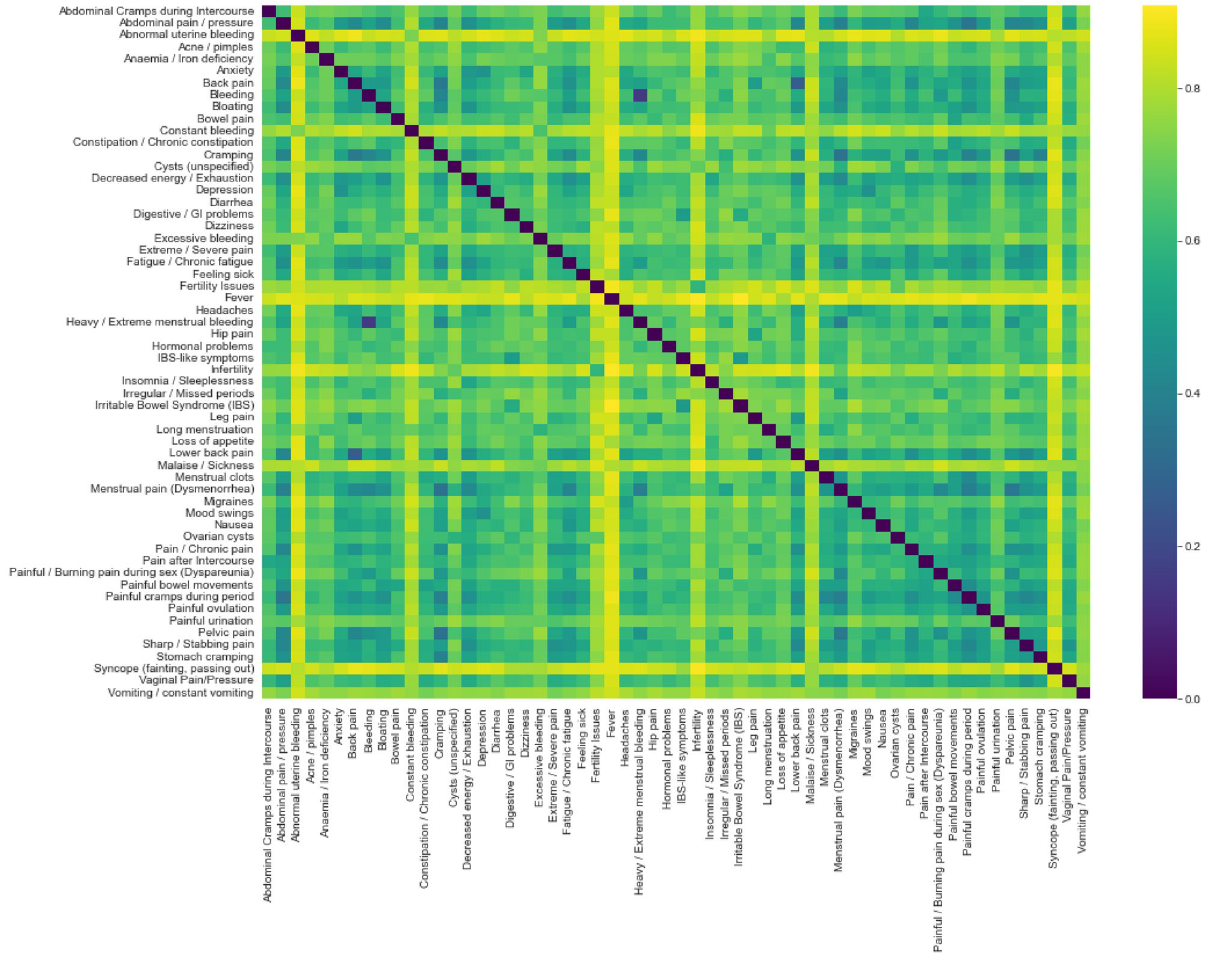
Figure 1. A heatmap that shows Jaccard Indices between each pair of symptom value vectors. A lighter color indicates a higher Jaccard Index, or a strong similarity between values. We use the Jaccard Index to identify potentially redundant